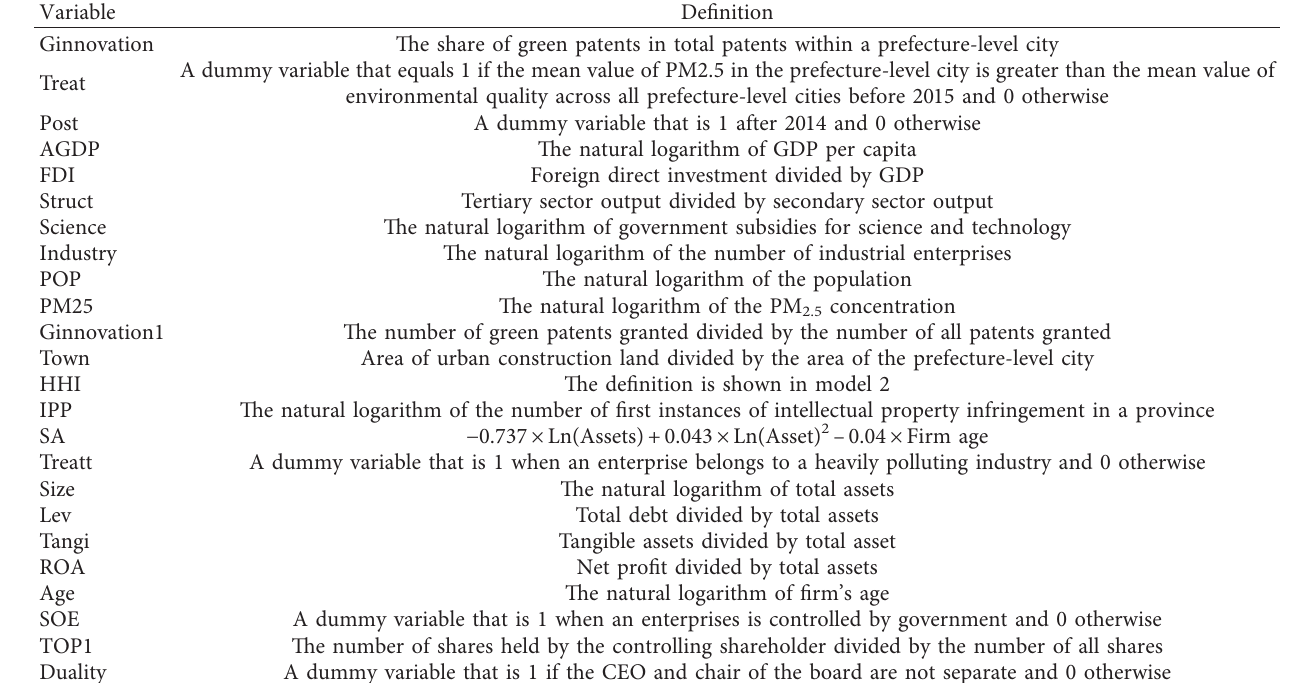
Table 1: Variables and definitions.